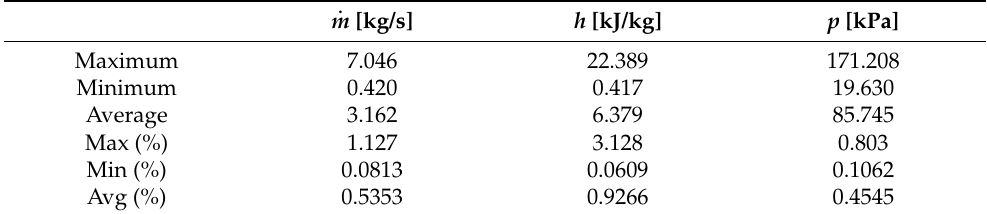
Table 8. Performance (absolute and relative errors) per output parameter for the PINN model of the recuperated Brayton cycle that used only Adam for optimization.